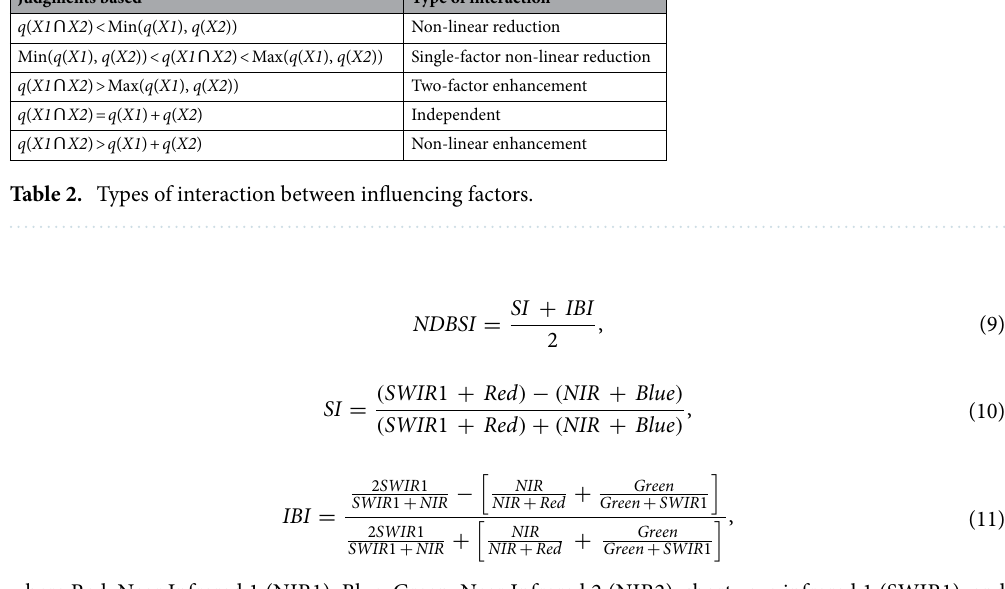
Judgments based Type of